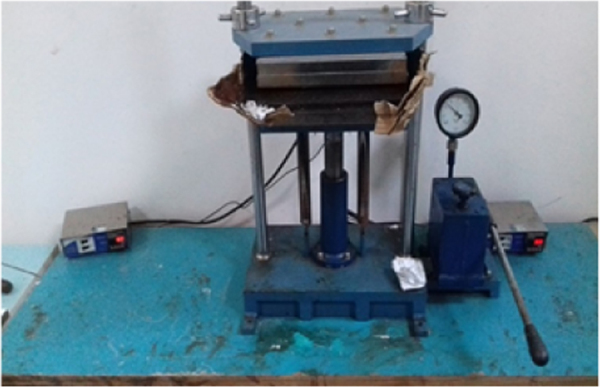
Compression molding.